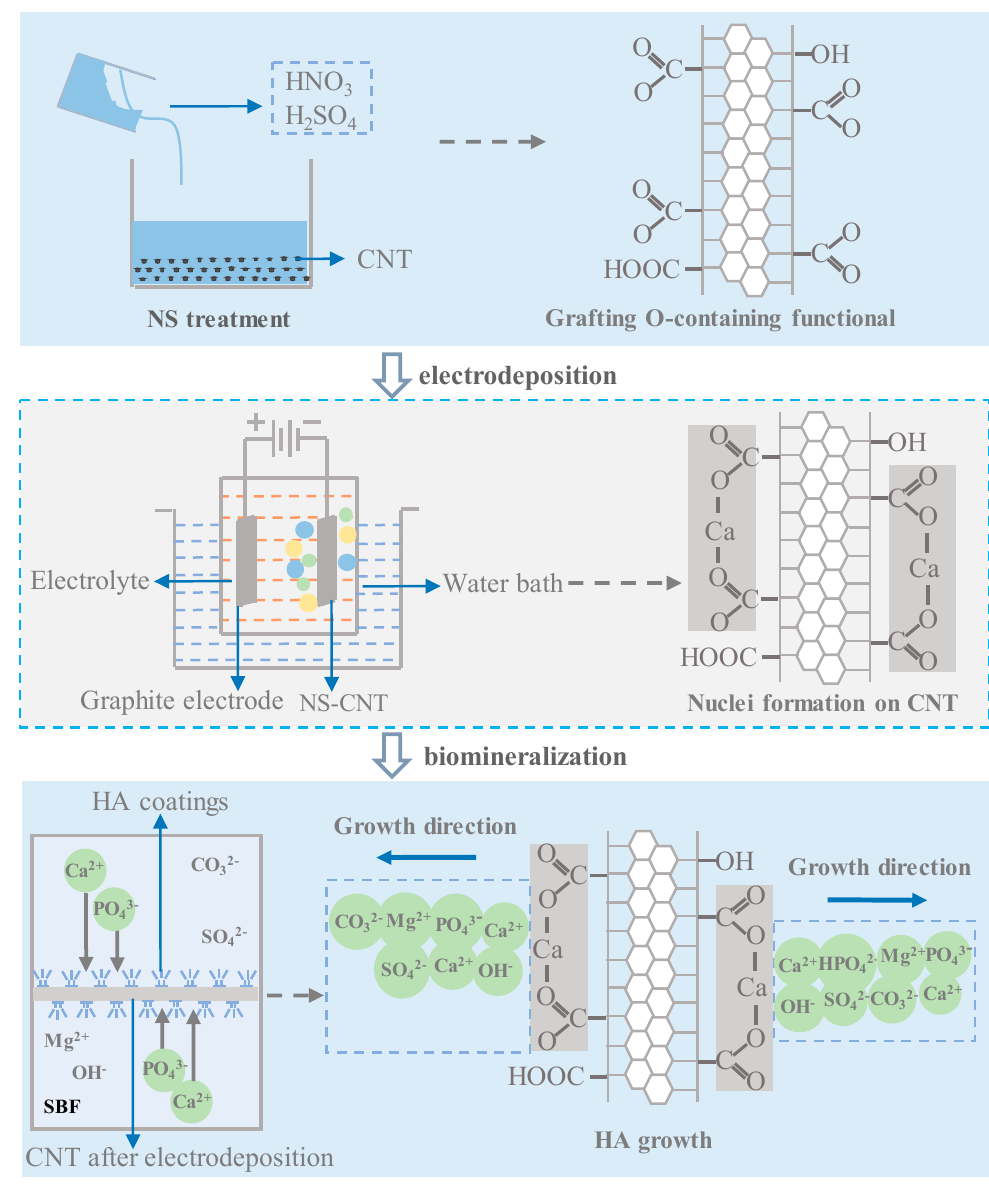
Figure 4. Possible preparation mechanism of nHA coating on the surfaces of CNTs.